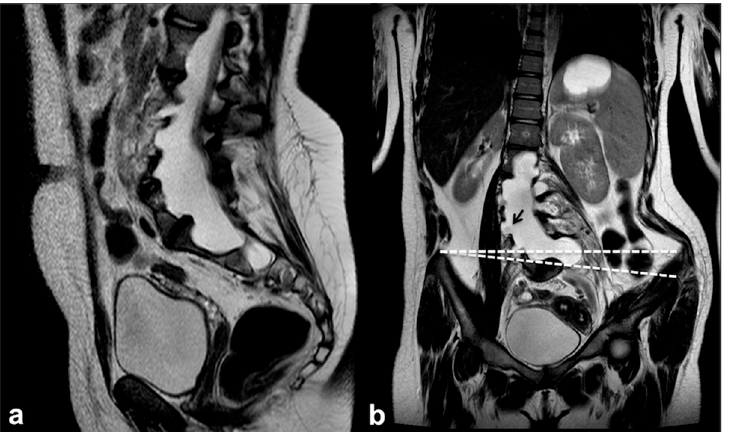
Figure 9. Sagittal ( a ) and coronal ( b ) TSE T2w of a large dural meningocele of the lumbar spine in a 15 year-old girl with NF1 showing: diffuse scalloping of vertebral bodies and pedicles; dural outpunching through the enlarged radicular foramina; periradicular CSF engorgement (black arrows); thoraco-lumbar scoliosis with right lateral pelvis tilt (on the coronal plan—dotted angle).